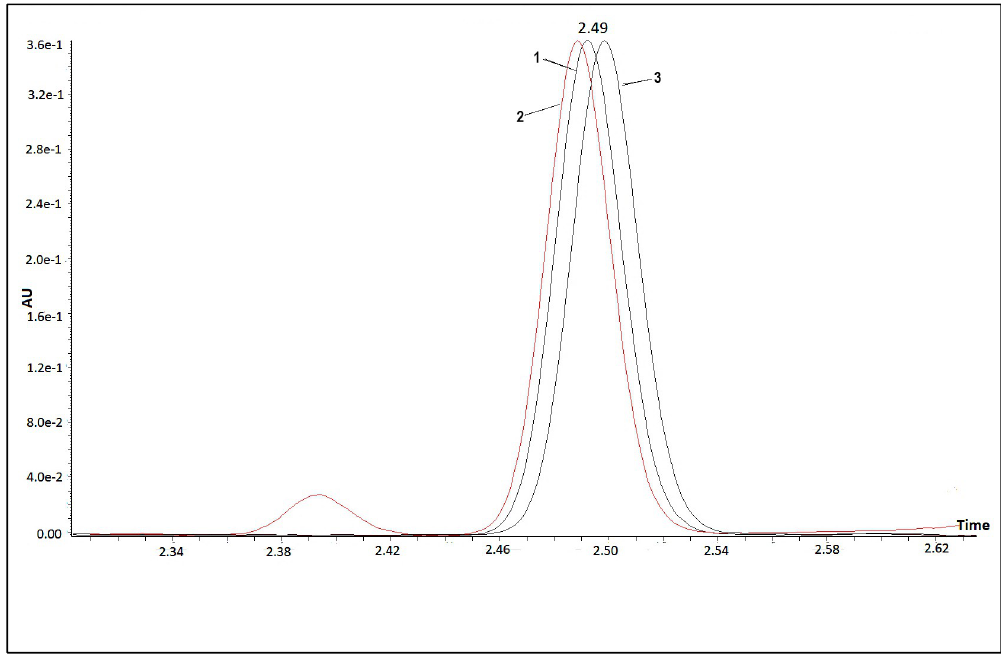
Figure 6. UPC 2 chromatogram, showing phytoene extracted from ripe tomatoes (peak 1), Norflurazon (peak 2) and chlorpropham (peak 3) treated D. salina cultures.